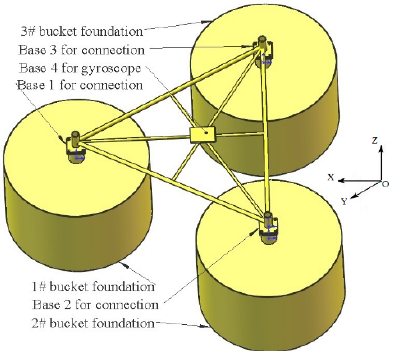
Figure 4. Schematic diagram of large-diameter multi-bucket foundation.